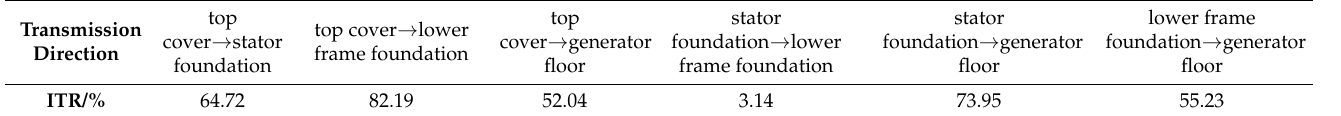
Table 5. Information-transmission rate between measurement points of condition